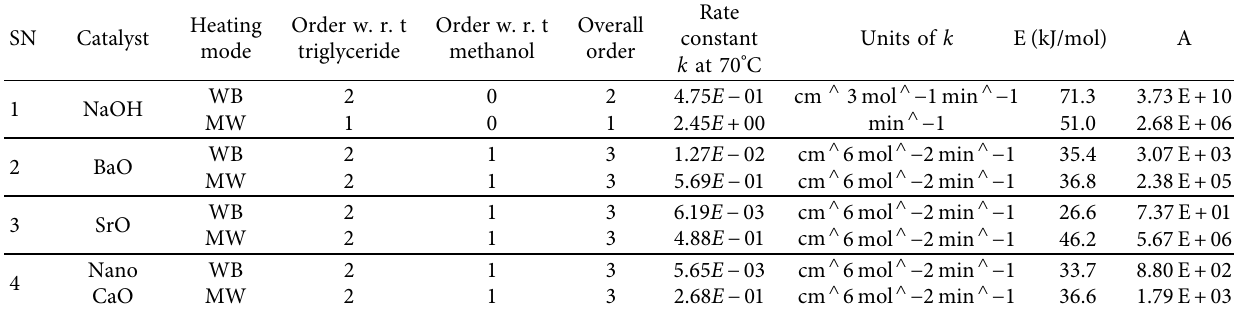
Table 4: Reaction orders, rate constants, activation energy, and preexponential